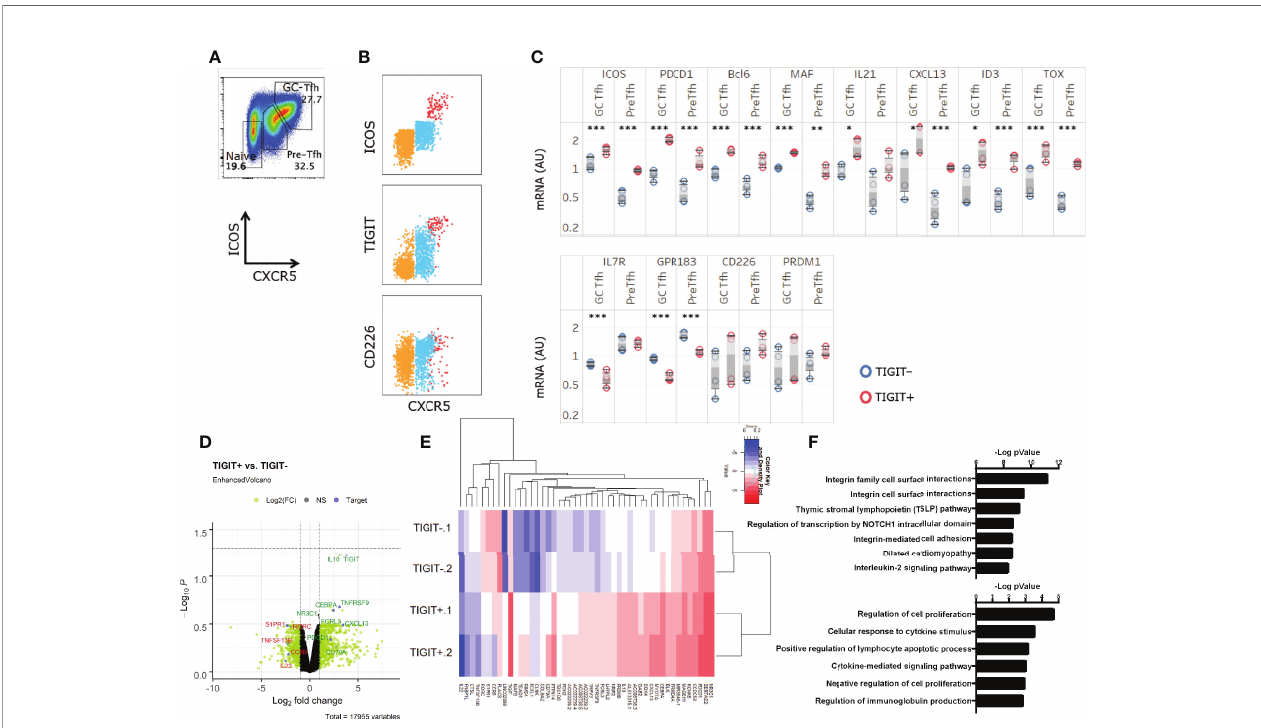
FIGURE 1 | TIGIT + GC-Tfh cells express a strong Tfh gene signature. (A) De fi nition of GC-Tfh cells (CXCR5 hi ICOS hi ), pre-Tfh cells (CXCR5 lo ICOS lo ), and naïve (CXCR5 - ICOS - ) in human tonsils in this study. (B) TIGIT, CD226, ICOS and CXCR5 expression on tonsillar CD4+ T cell with colors depicting each pre-gated subset (Naïve – Orange, Pre-Tfh – Blue, GC-Tfh – Red). (C) GC-Tfh and Pre-Tfh subsets were each sorted according to TIGIT expression, and Tfh-associated gene expression was determined. Paired t-test. *p < 0.05; **p < 0.01; ***p < 0.001. (D, E) The transcriptome of TIGIT + and TIGIT - pre-Tfh cells was analyzed by RNAseq. Differentially expressed genes are shown in a volcano plot with selected genes of interest highlighted in green if upregulated and downregulated genes listed in red (D) and in a heat map the 47 most signi fi cant genes are shown in (E) . (F) The top differential pathways between TIGIT + and TIGIT - pre-Tfh cells. (top) EnrichR (39) using pathway databases from BioPlanet 2019. (bottom) Biological Process 2018. Data is depicting 2 biological replicates per